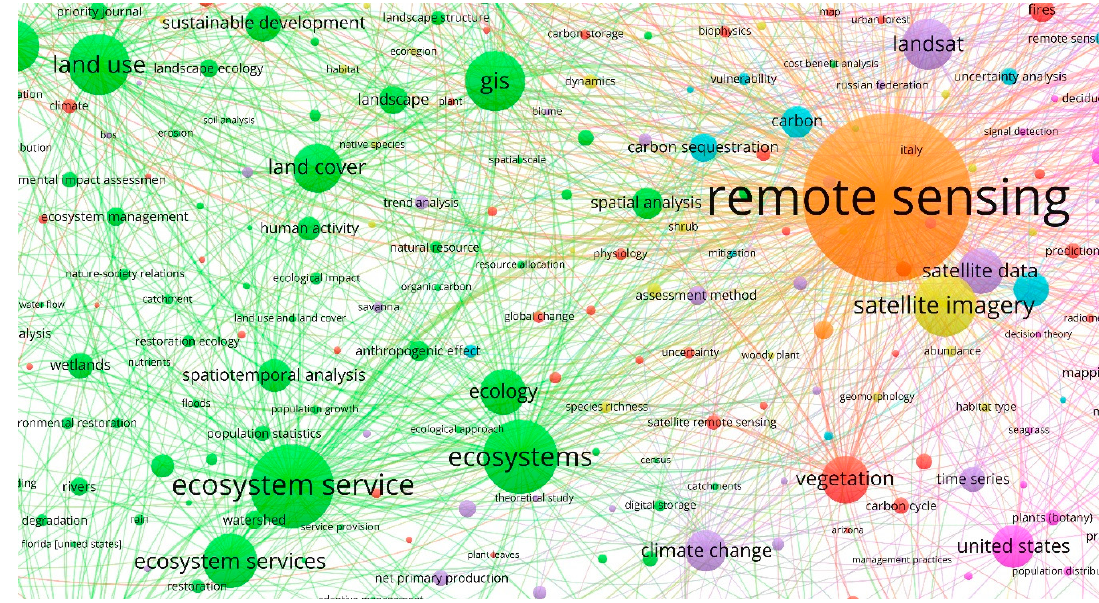
Figure 7. Links of “Ecosystem Service” keyword (1976–2019).